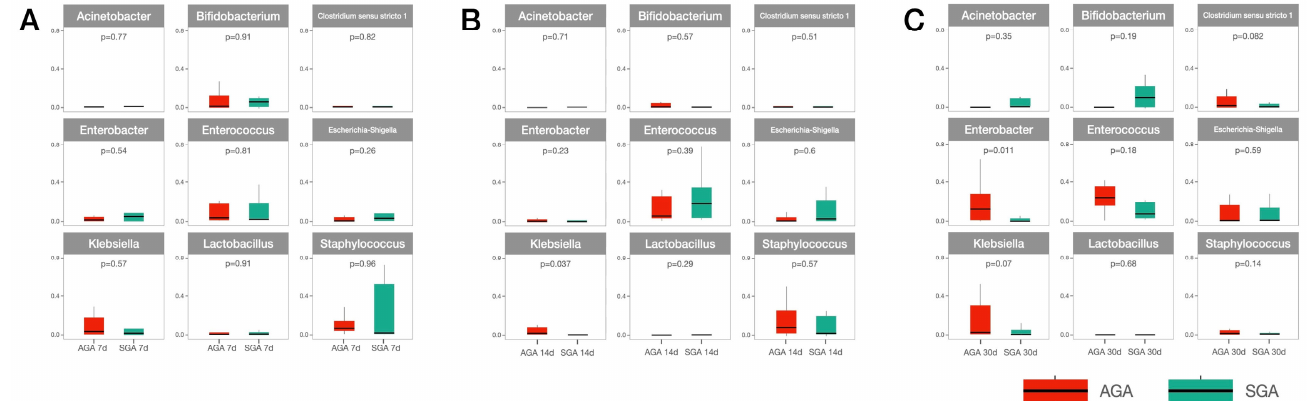
Figure 2. Relative abundance of the dominant bacterial genera in the AGA and SGA groups. Samples collected on days ( A ) 7, ( B ) 14, and ( C ) 30. Abbreviations: AGA, appropriate for gestational age; SGA, small for gestational